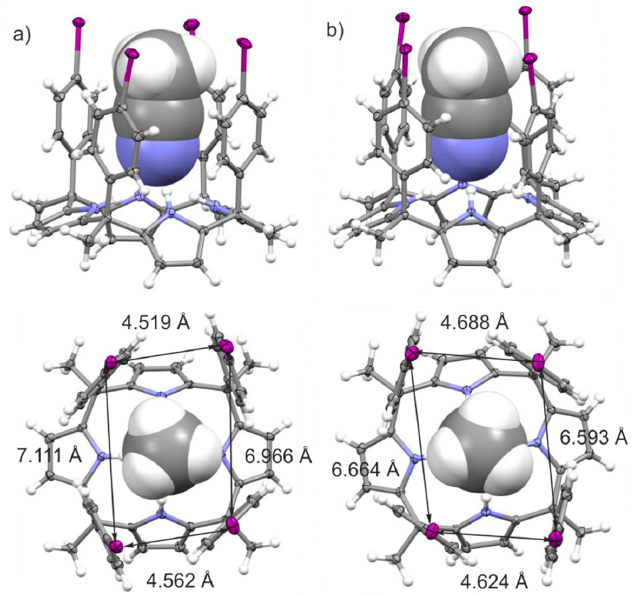
Figure 1. Perspective (top) and zenithal (bottom) views of the X-ray asymmetric units of polymorphs A ( a ) and B ( b ). Distances in Å. Thermal ellipsoids for C, N and I atoms set at 50% probability; H atoms are shown as spheres of 0.20 Å diameter. The bound acetonitrile (ACN) molecule is shown as a space-filling